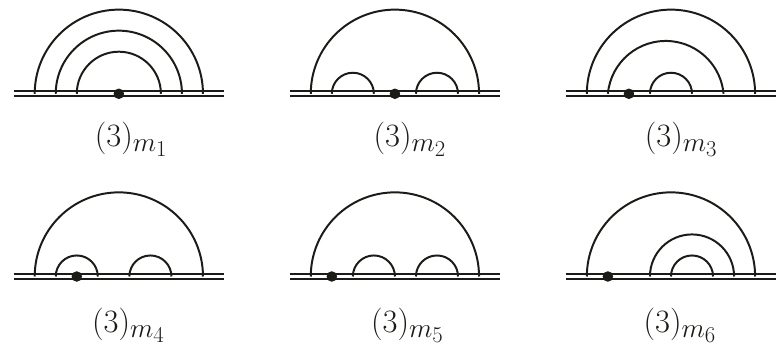
Figure 11 . Fermion ladder